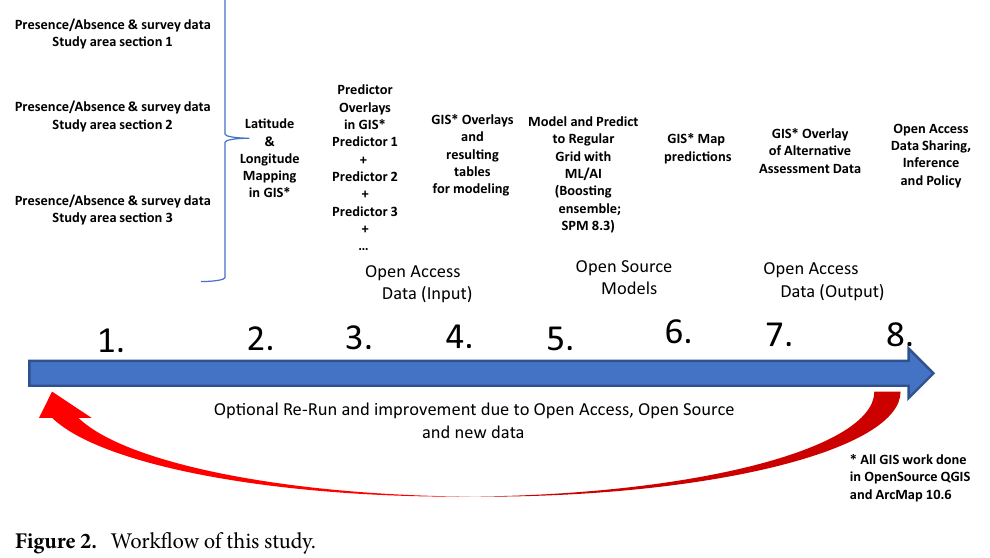
Presence/Absence & survey data Study area sec(cid:13)on 1